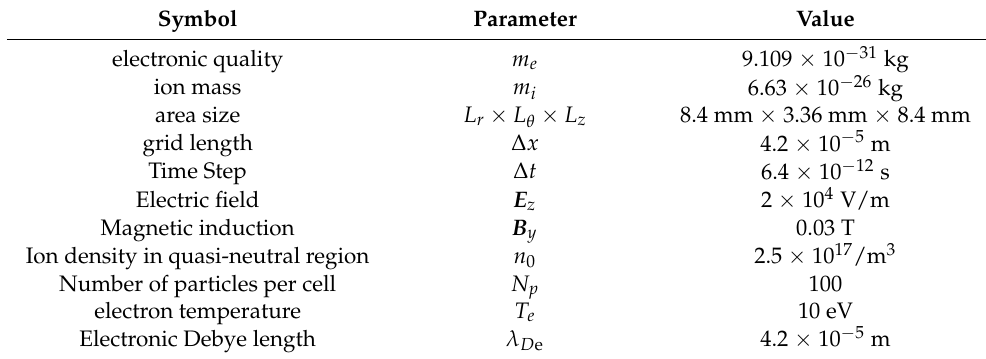
Table 1. Numerical parameters used in the 2D3V PIC simulation.